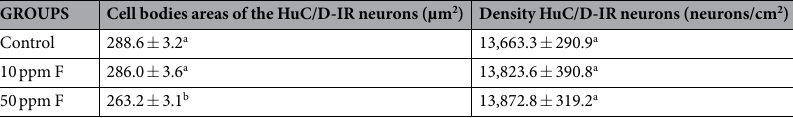
Table 2. Means and standard errors of the values of the cell bodies areas and density of the HUC/D-IR myenteric neurons of the duodenum of rats exposed or not to F chronically, through the drinking water for 30 days. Animal groups: Control (deionized water-0 ppm F), 10 ppm F, and 50 ppm de F. In the quantitative analysis the Fisher’s test was applied but no significant difference was observed among the groups. In the morphometric analysis, means followed by different letters in the same column are statistically different according to Tukey’s test (p < 0.05).